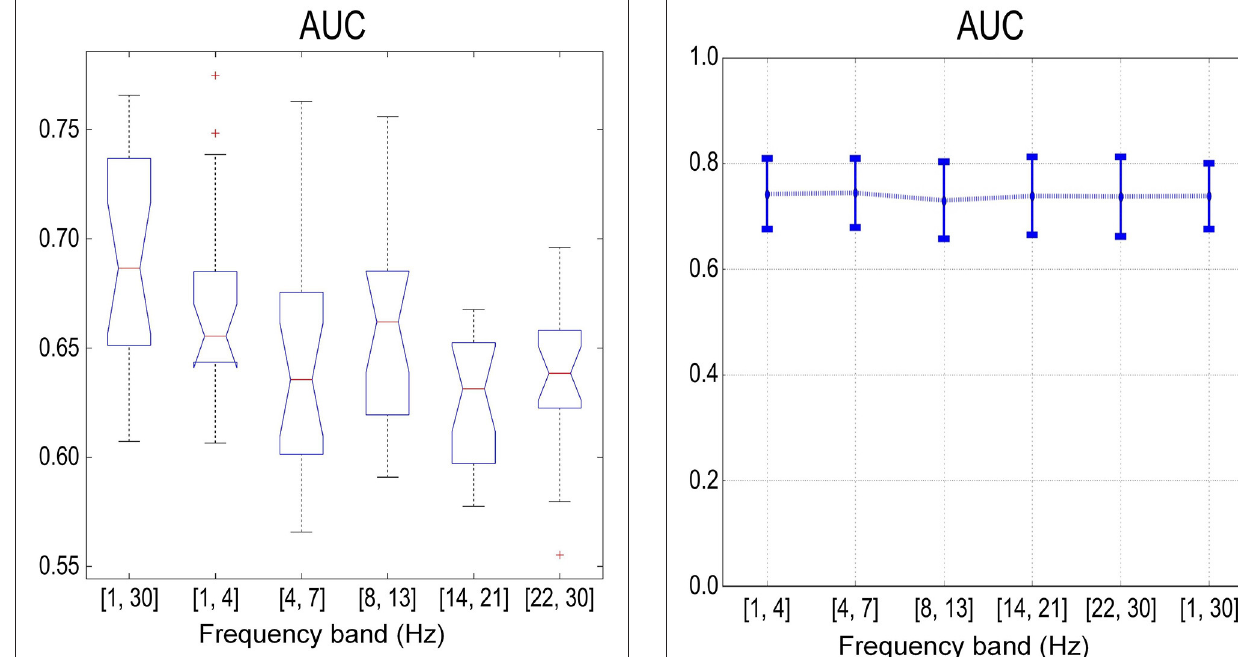
FIGURE 9 | Mean and standard deviation of sample-based performance (AUC) across different frequency bands using the combination of MRCP and SMR